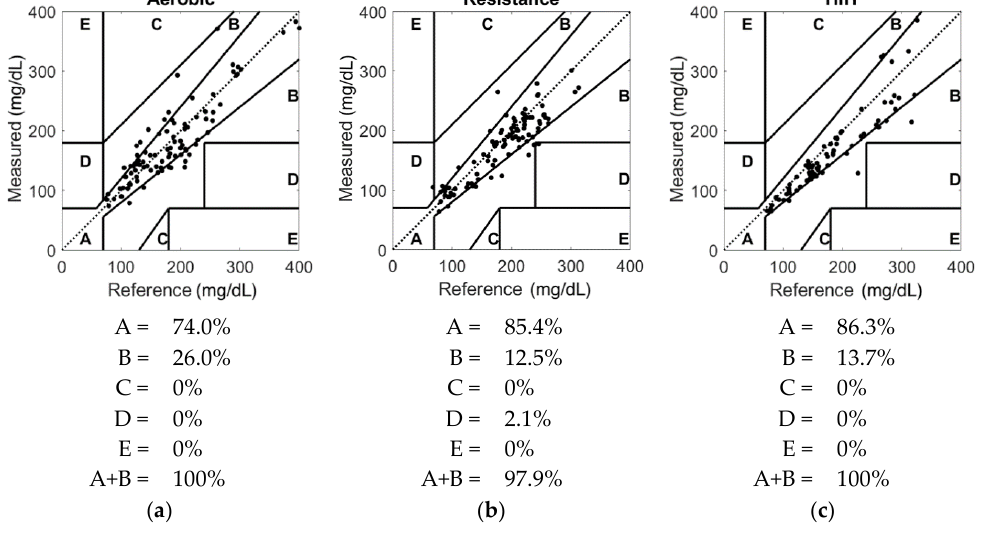
Figure 2. Clarke error grid analysis showing paired continuous glucose monitoring (CGM) and capillary (reference) glucose during ( a ) aerobic, ( b ) resistance and ( c ) high intensity interval training (HIIT) exercise. In these scatterplots, the diagonal represents perfect agreement between capillary and sensed glucose. The regions (or zones) labelled A through E represent varying degrees of accuracy of glucose estimations. Zone A contains values within 20% of the reference sensor. Zone B values deviate more than 20% but would not lead to inappropriate treatment. Values within zone C would lead to overcorrecting while those in zone D represent a potentially “dangerous failure to detect and treat”. Lastly, zone E would result in opposite treatment decisions (e.g., treatment of hypoglycemia for hyperglycemia and vice versa)